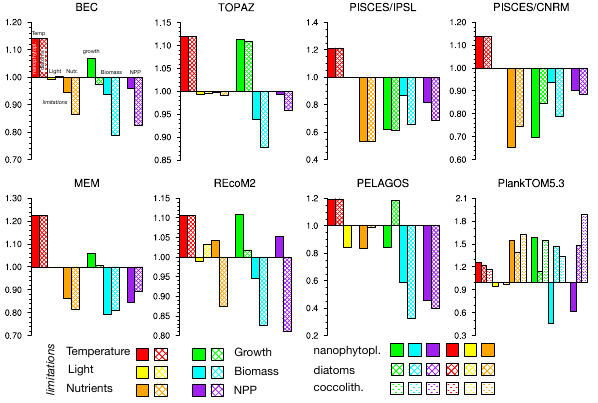
Figure 10. Relative change in temperature limitation factor (red), light limitation factor (yellow), nutrient limitation factor (orange), growth rate (green), biomass (light blue) and NPP (purple) for nanophytoplankton (full), diatoms (hatched) and coccolithophores (dotted) at the surface of the low latitudes for all models where the full equations were available. An increase in limitation factor de- notes weaker limitation, which leads to stronger growth. The rela- tive change in a variable is the ratio between the 2081–2100 average and the 2012–2031 average. A value of 1 means no change, 1.2 cor- responds to a 20% increase, 0.8 corresponds to a 20% decrease. The product of the relative change in temperature, light and nutri- ent limitation results approximately in the relative change in growth rate. See main text for further